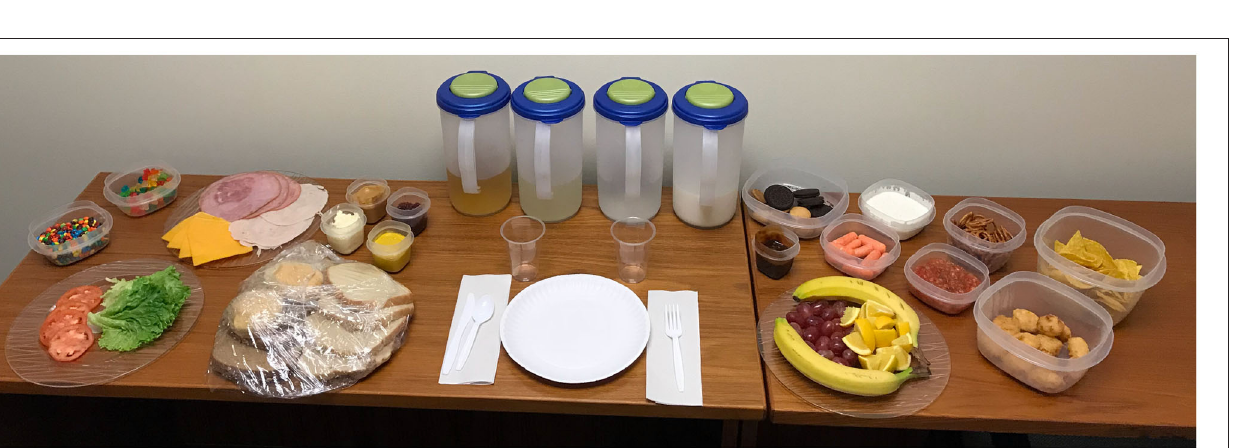
FIGURE 1 | Test meal food